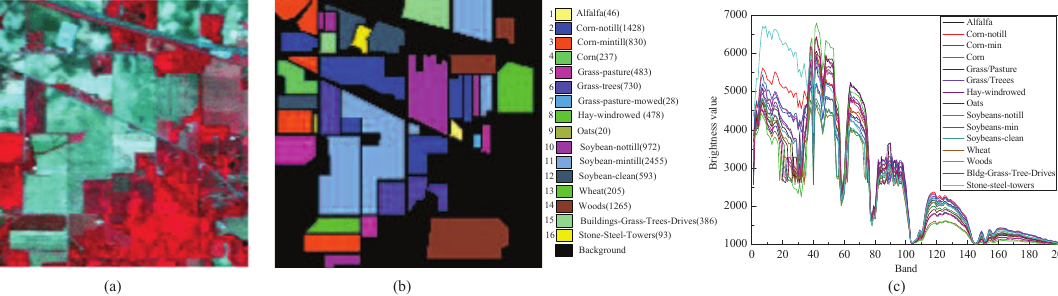
Figure 4. Indian Pines hyperspectral image: ( a ) HSI in false color; ( b ) ground truth; and ( c ) spectral curve. (Note that the number of samples for each class is shown in brackets.)